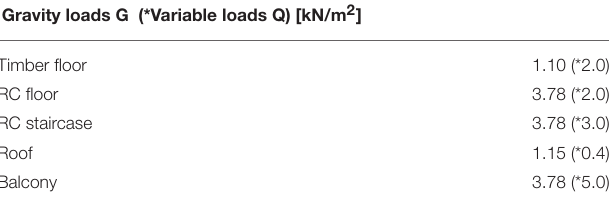
TABLE 2 | Gravity and variable